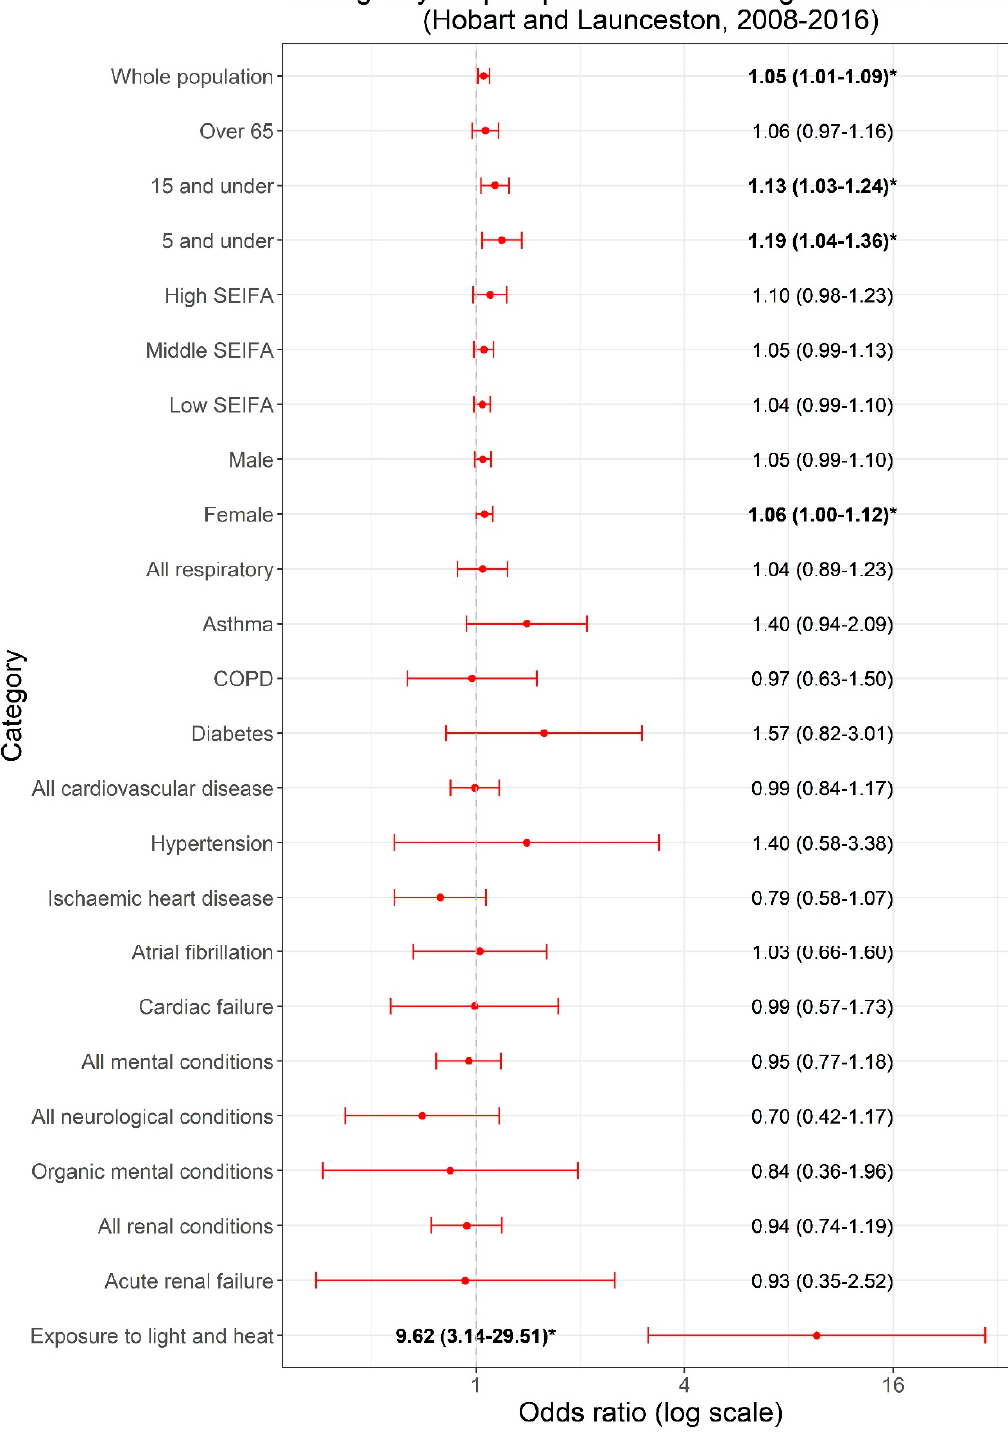
Figure 2. Odds ratios and 95% confidence intervals for the association between ED presentations for specific population characteristics, diagnostic groups, and heatwaves in Hobart and Launceston, Tasmania (2008–2016), adjusted for public holidays and PM 2.5 (* and bold indicates p < 0.05). Tasmania (2008–2016), adjusted for public holidays and PM